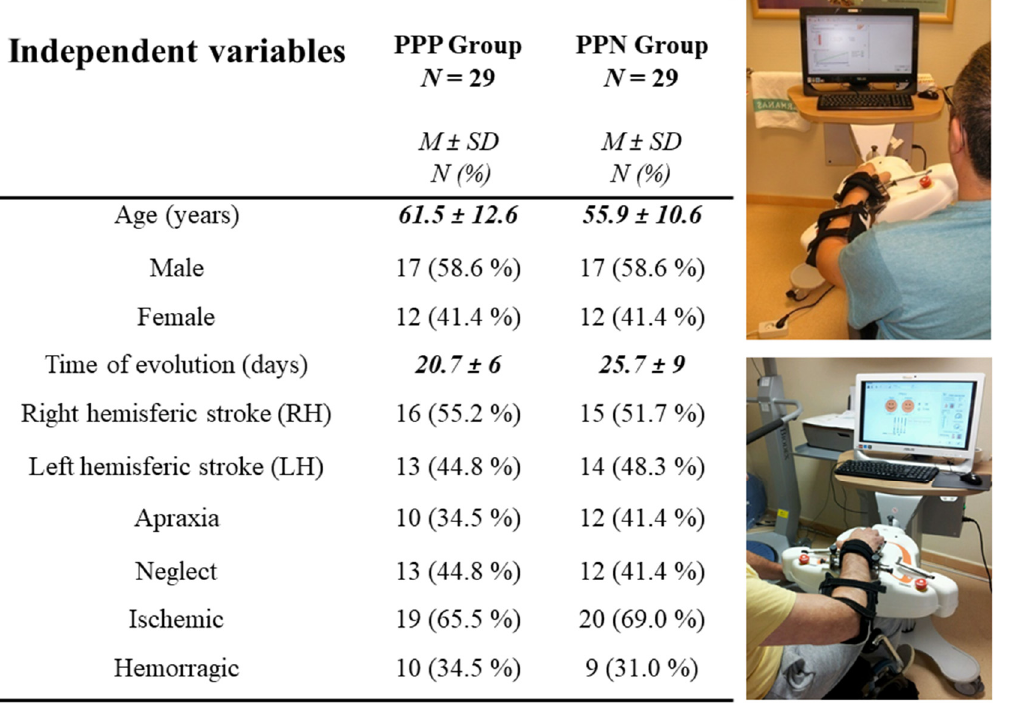
Figure 2. Demographic and clinical characteristics of the experimental groups. PPP: positive prognosis profile; PPN: negative prognosis profile; M:mean; SD: standard deviation; N: sample size.Statistical significant differences were found between variables in black ( p < 0.000).